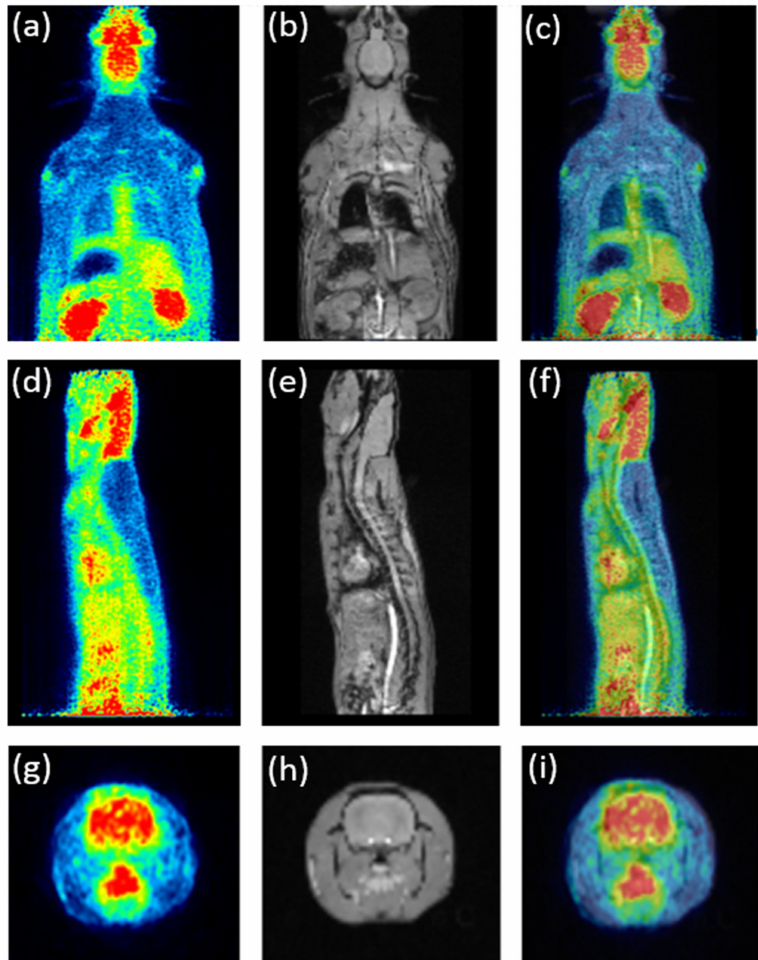
Figure 11. A healthy rat study was conducted using 38.9 MBq of 18 F-FDG. The rat with injected anesthesia was mounted on the bed, scanned PET (15 min), and underwent T1-weighted MRI (~6 min). The image was reconstructed by the system’s default reconstruction method, 3D-MLEM, with 18 iterations. Shown and labeled are the three different views of PET images, MRI images, and PET/MRI fused images. Coronal ( a – c ), sagittal ( d – f ), and transverse ( g – i ). ( a , d , g ) PET images, ( b , e , h ) MRI images, and ( c , f , i ) PET/MRI fused